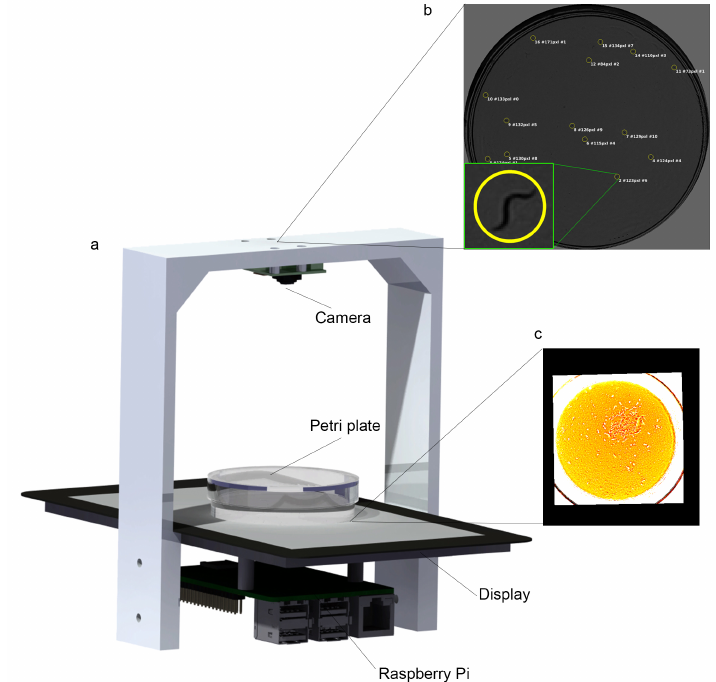
Figure 1. Scheme ( a ) Lifespan machine used. ( b ) A Petri plate image, with a zoom of an example worm. ( c ) Illumination pattern example which is drawn on